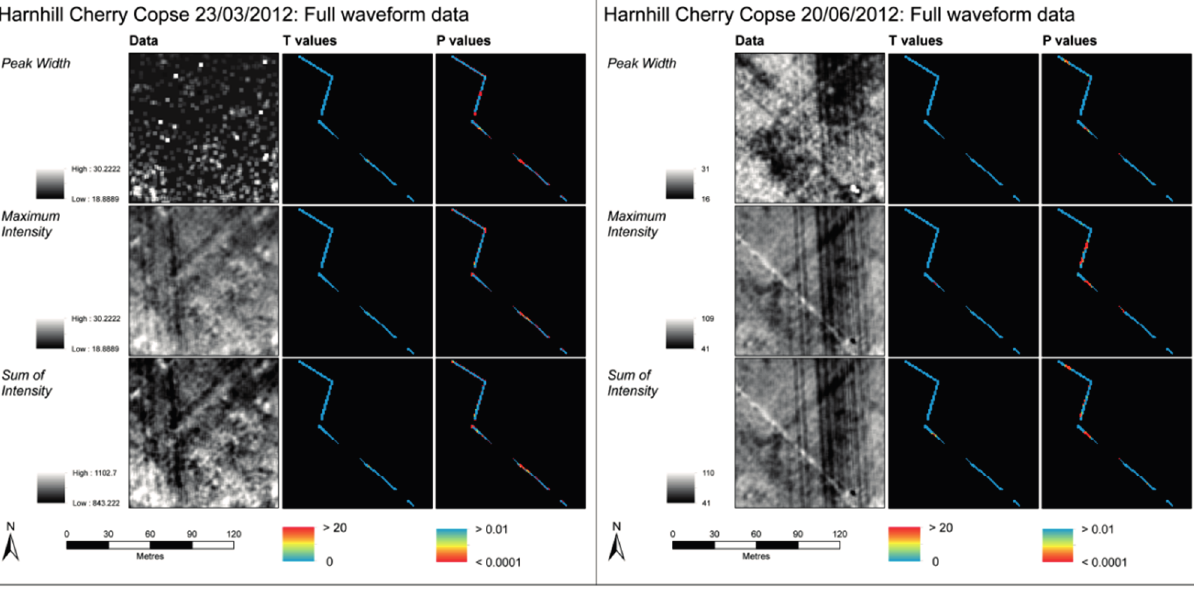
Figure 12. Metrics from airborne LiDAR full waveform data for Harnhill Cherry Copse field and T -values and P -values indicating localised